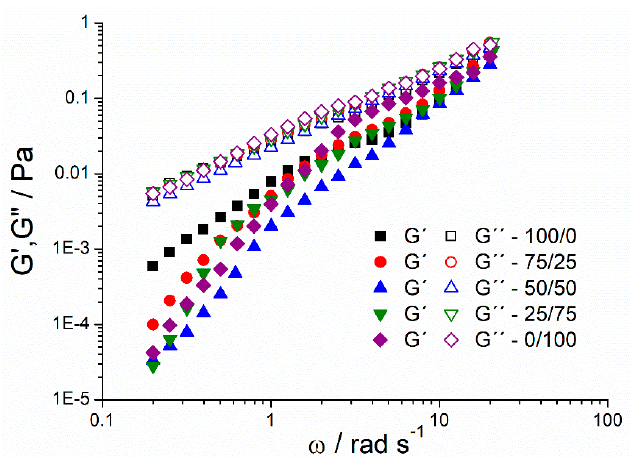
Figure 4. Mechanical spectra for ecological mandarin emulsions as a function of Tween/Span ratios. Materials 2020 , 13 , x